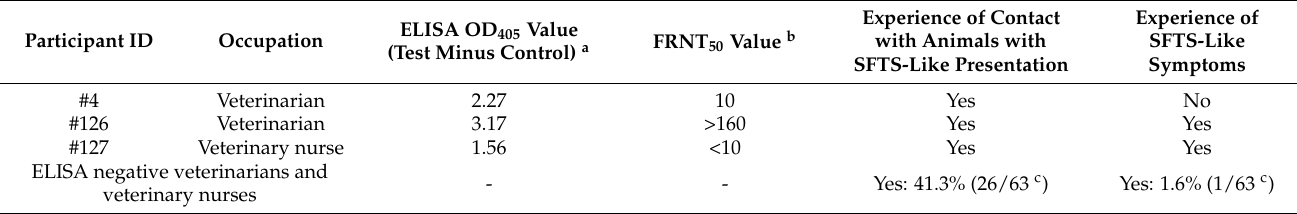
Table 2. Characteristics of the serological reaction to severe fever with thrombocytopenia syndrome virus and the results from the